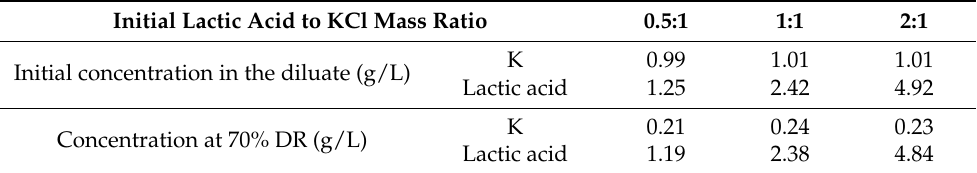
Table 2. Experimental results at 70% demineralzation rate (DR) for a feed solution of lactic acid and KCl.